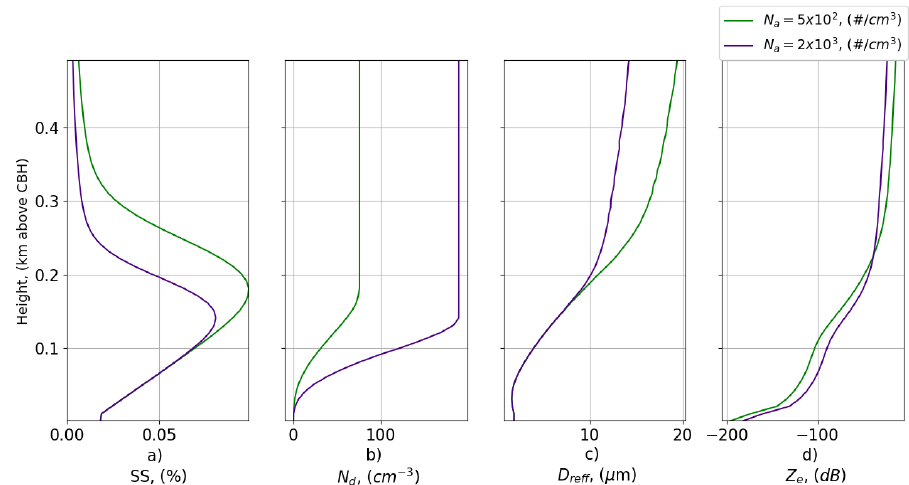
Figure A1. Twomey effect of a cloud formed from the activation of ammonium sulfate particles. Supersaturation (SS) ( a ), droplet number concentration ( N d ) ( b ), droplet effective radius ( D ref f ) ( c ), and radar reflectivity ( Z e ) ( d ) profiles inside the